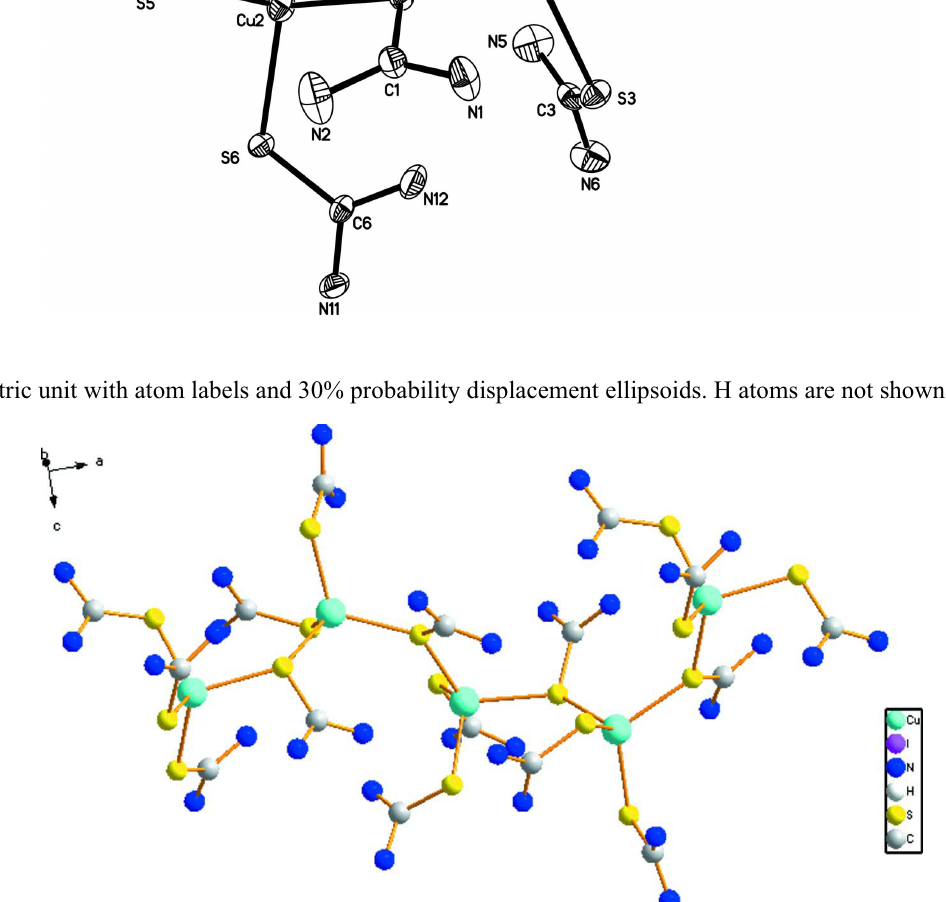
Figure 2 Part of the one-dimensional helical chain structure of the title complex. catena -Poly[[[bis(thiourea- κ S )copper(I)]- µ -thiourea- κ 2 S : S ] iodide acetonitrile